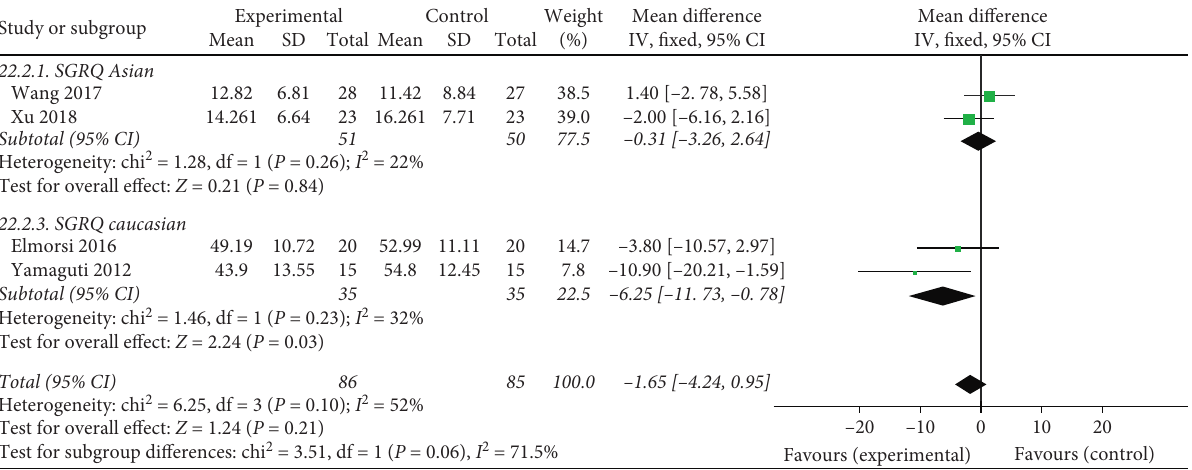
Figure 7: Effects of breathing exercises on QoL using